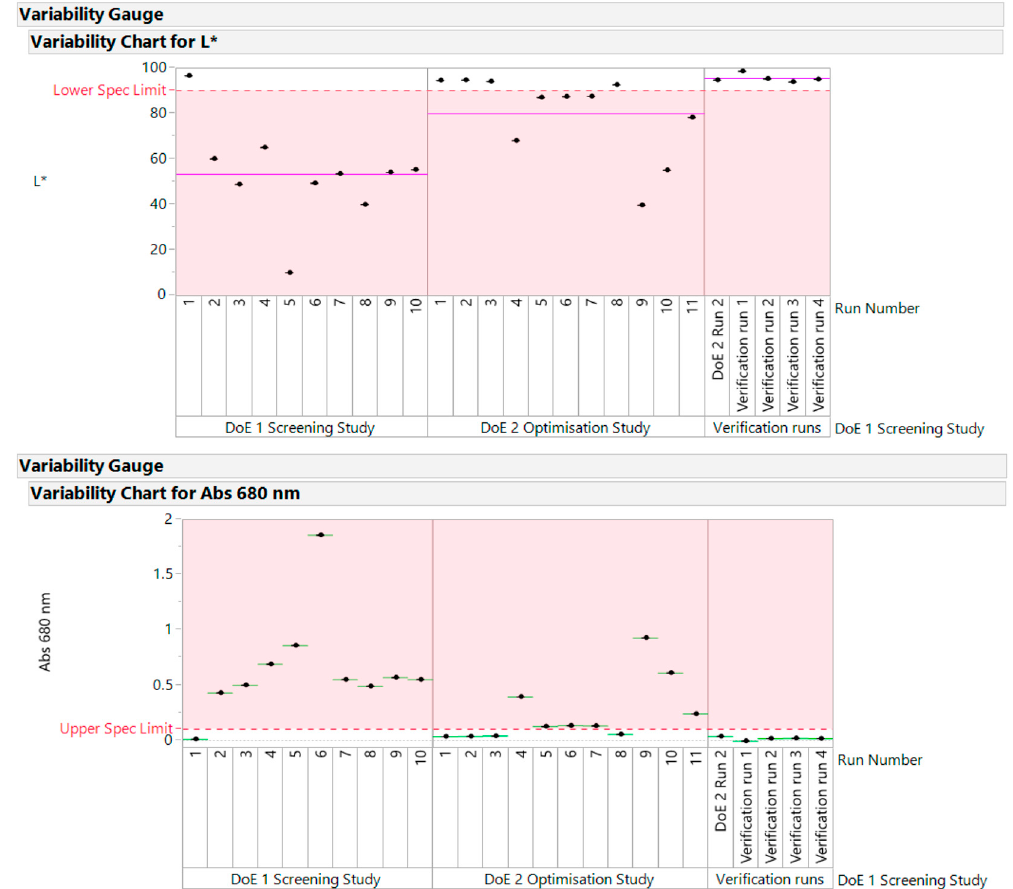
Figure 9. Variability gauge plot for data across all studies.